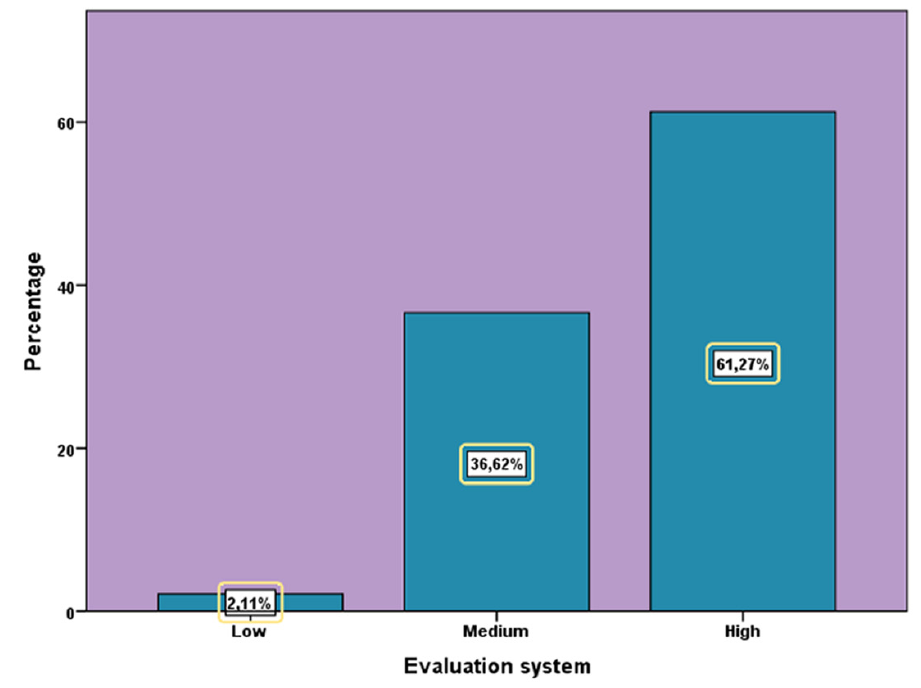
Fig. 6. Analysis of the dimension: Evaluation